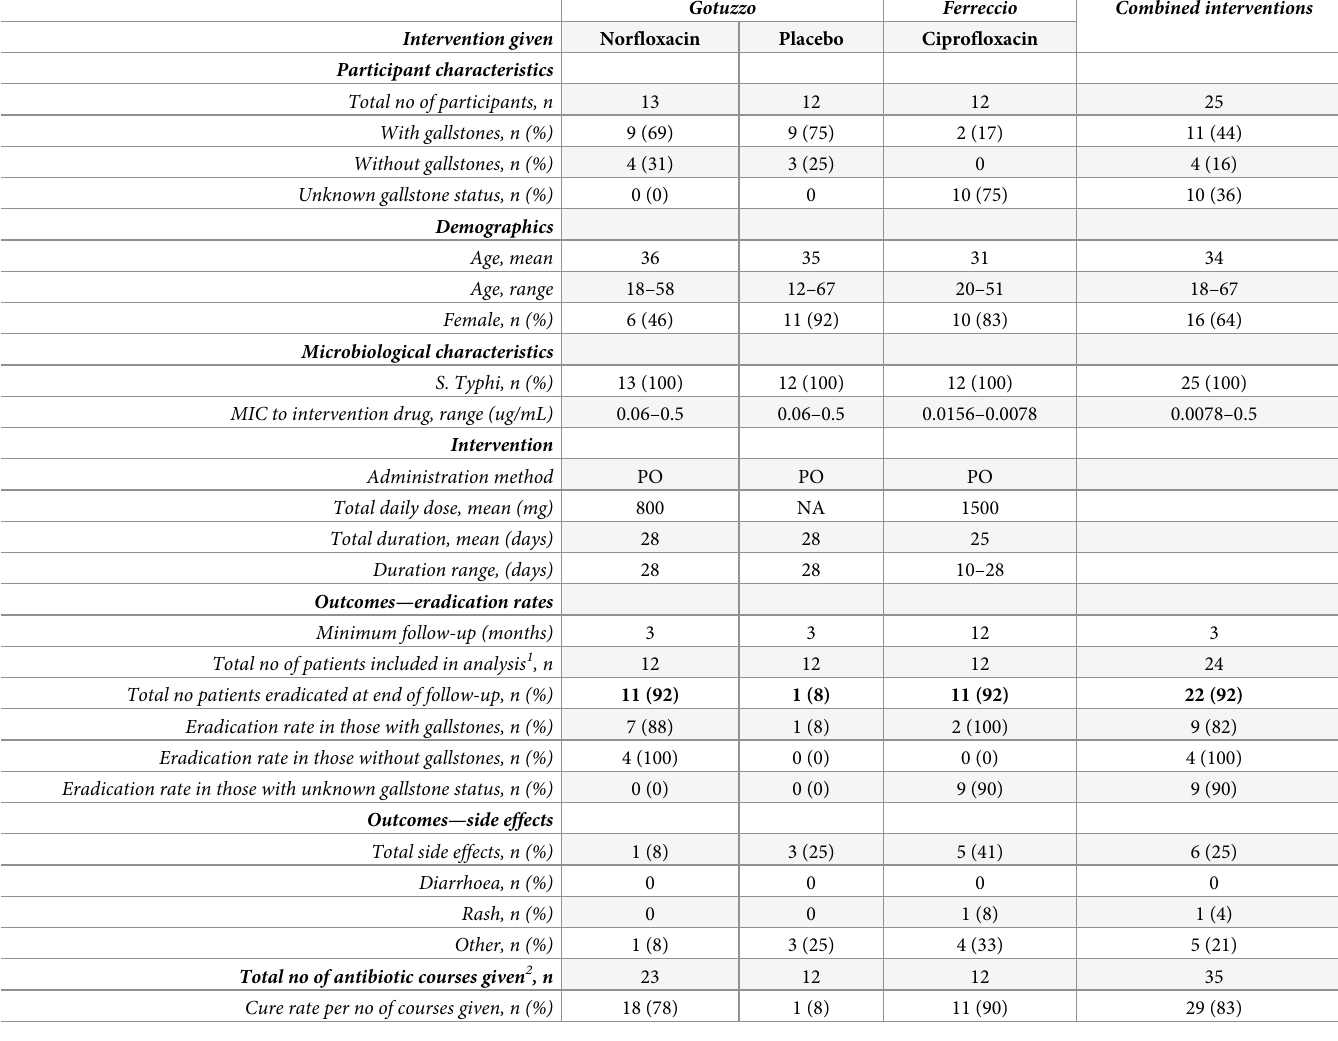
Table 2. Summary of results from studies using fluoroquinolone antibiotics to treat S . Typhi chronic